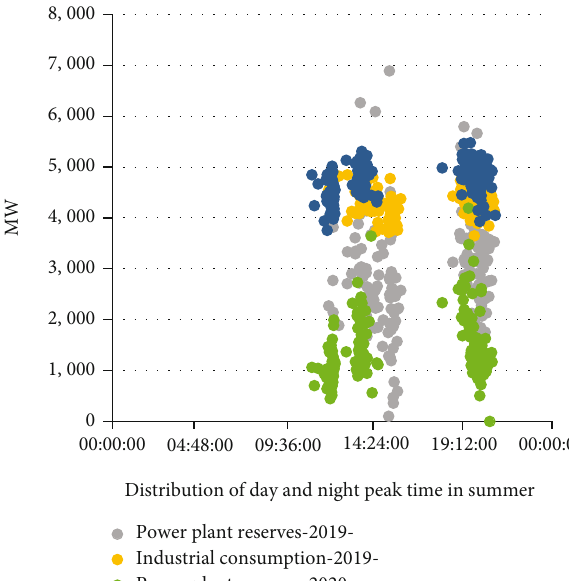
Figure 5: Comparison of industrial electricity consumption and power plant reserves at the peak moment in 2019 and 2020. Extracted from the Iran Grid Management Company (IGMC) database.